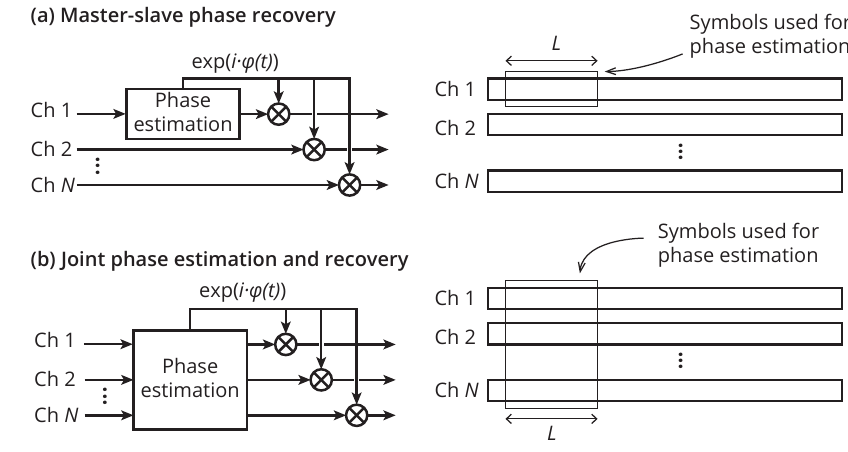
Figure 6. Principle of ( a ) master-slave phase recovery and ( b ) joint phase